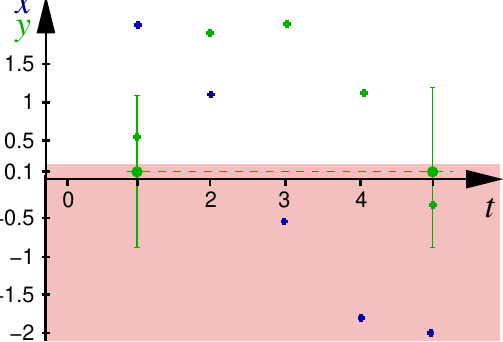
Figure 2. Model-based monitoring of temporal conditions under interval-type uncertainty and partial